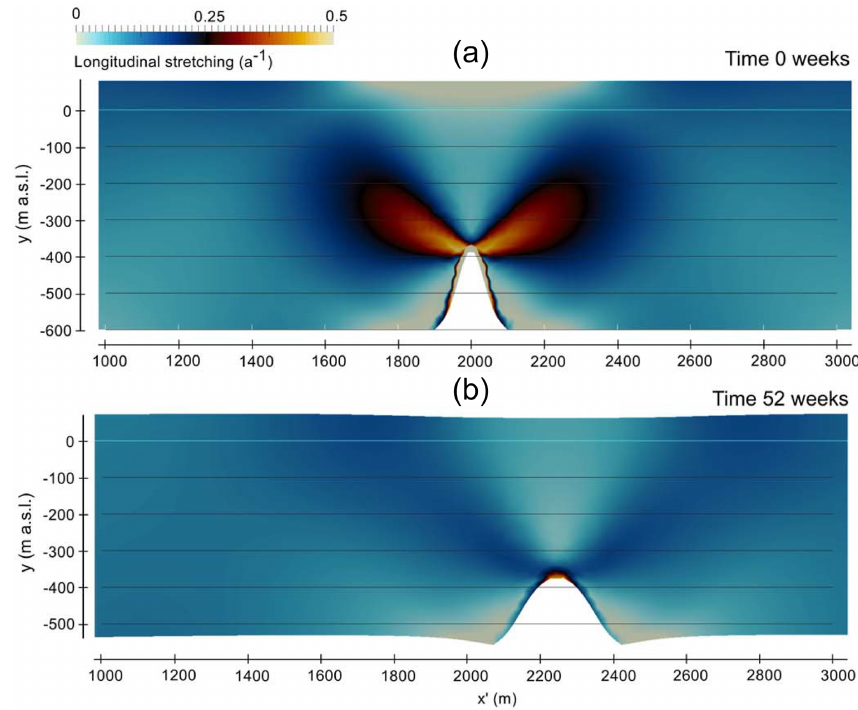
Figure 5. Evolution of basal crevasse geometry in Elmer/Ice. (a) shows initial geometry of basal crevasse experiment. (b) shows evolved geometry under longitudinal stretching after 1 year. The effect of longitudinal stretching on the shelf widens the basal